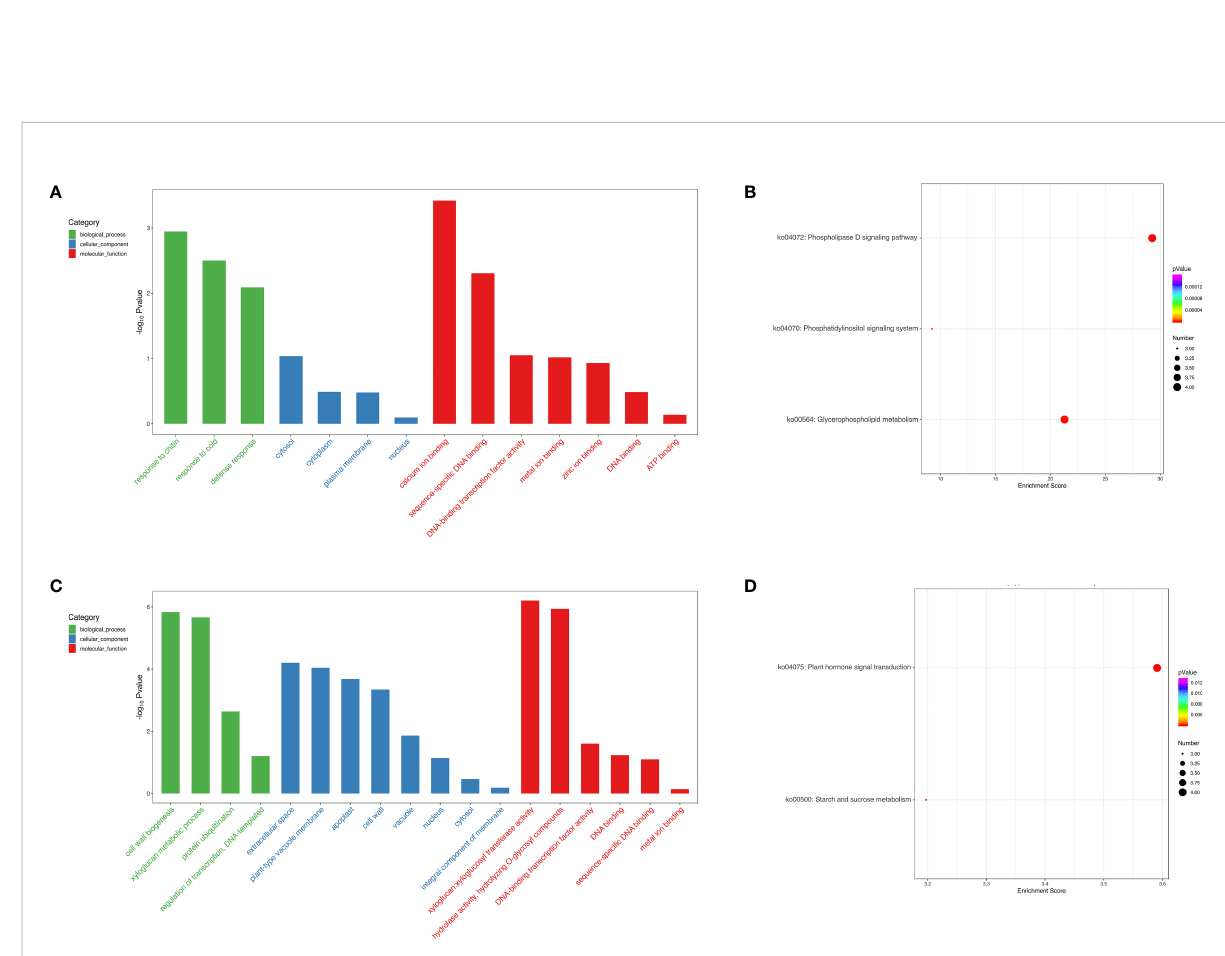
FIGURE 9 Functional Gene Ontology (GO) and Kyoto Encyclopedia of Genes and Genomes (KEGG) analysis of long non-coding RNA (lncRNA) target genes. GO enrichment analysis of lncRNA targets genes in FC vs FNC (A) and FB vs FC (C) . KEGG enrichment analysis of lncRNA targets genes FC vs FNC (B) and FB vs FC (D)